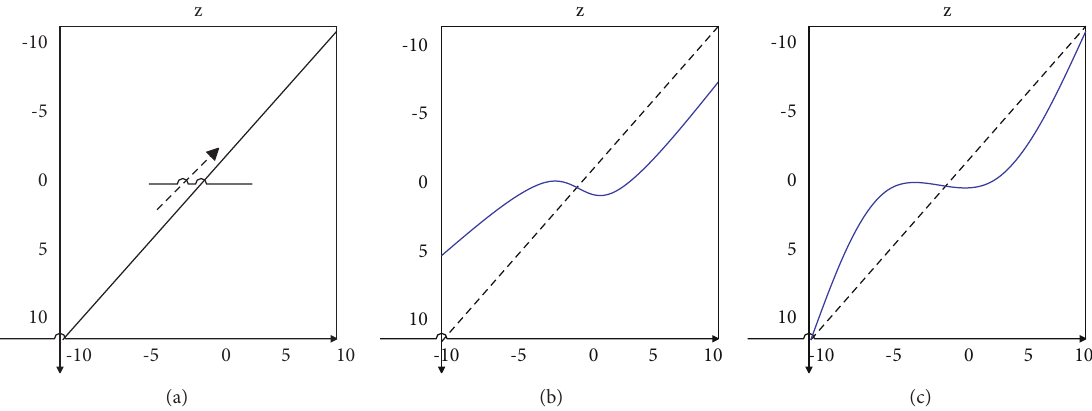
Figure 2: Estimated image under various penalty functions. (a) Hard. (b) Lasso. (c) SCAD takes Q � 2 and a �